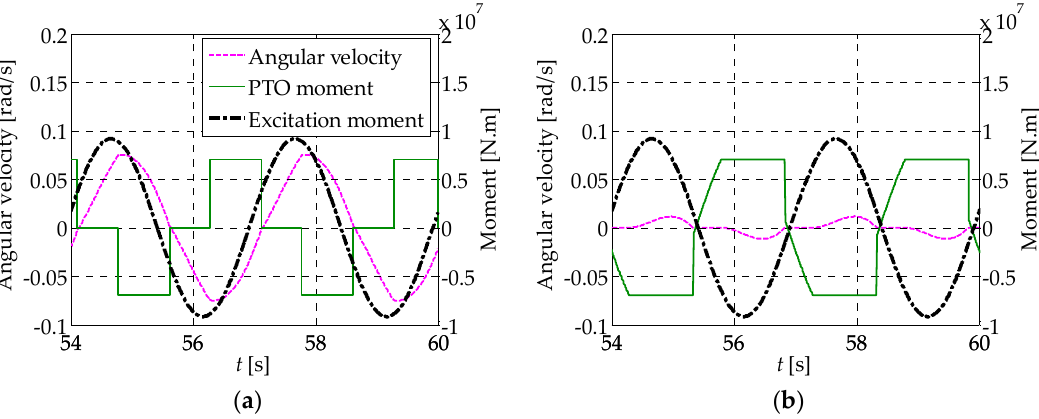
Figure 11. Time history of the pitch angular velocity, PTO moment and excitation moment for the coulomb load at M p = 7 × 10 6 N·m and T = 3.0 s when maximum relative capture width is achieved: ( a ) under declutching control; ( b ) under resistive control.